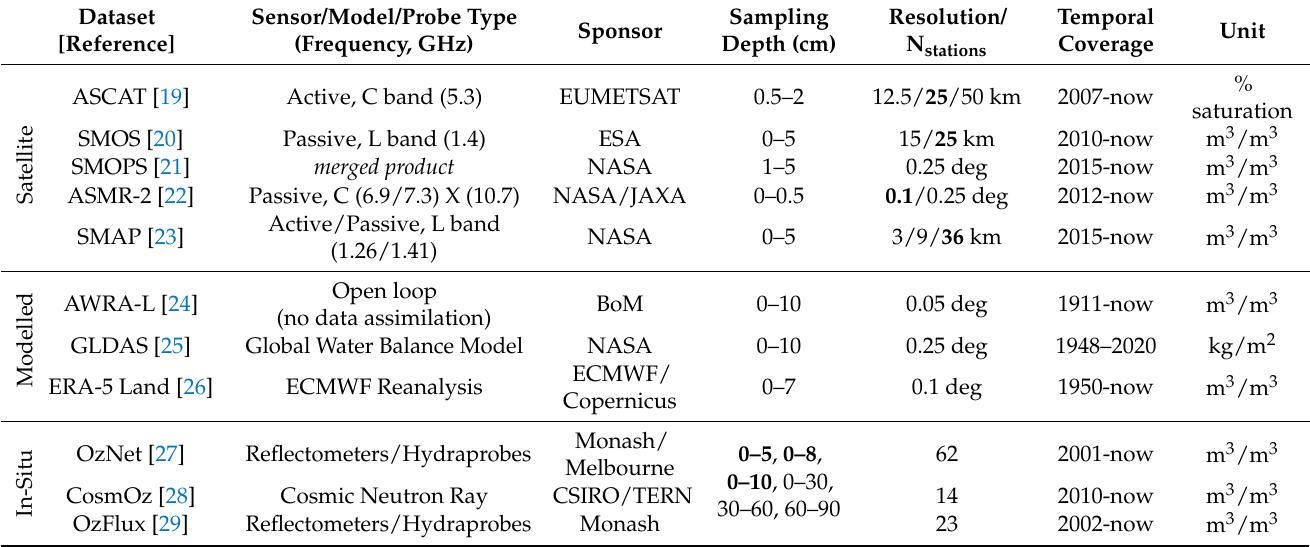
Table 1. Summary of the datasets used in this study. Bold text indicates the resolution and sampling depths used in this